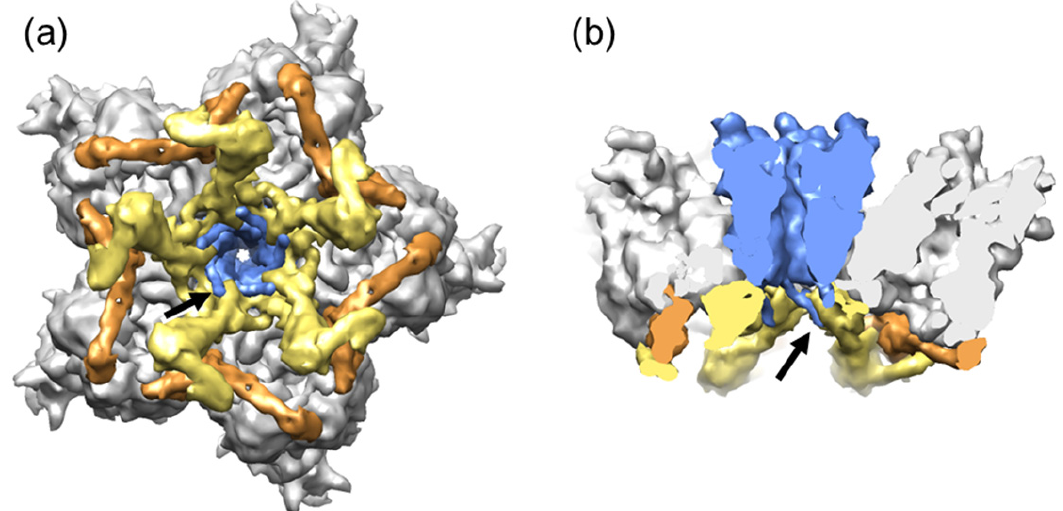
Figure 3. Organization of the AdV vertex region (GOS). ( a ) View from inside the capsid looking at the 5-fold icosahedral symmetry axis. ( b ) Side view showing a transversal section across the penton. The five peripentonal hexons are shown in gray; penton base in blue; polypeptide IIIa in yellow; and the GOS copy of polypeptide VIII in tan. Surfaces were created from high resolution structures in PDB ID 3IYN [4], using UCSF Chimera software [113]. Notice the N-terminal penton base arms (arrows) intercalating between IIIa monomers, and the radial position of polypeptide VIII, wedged between IIIa and